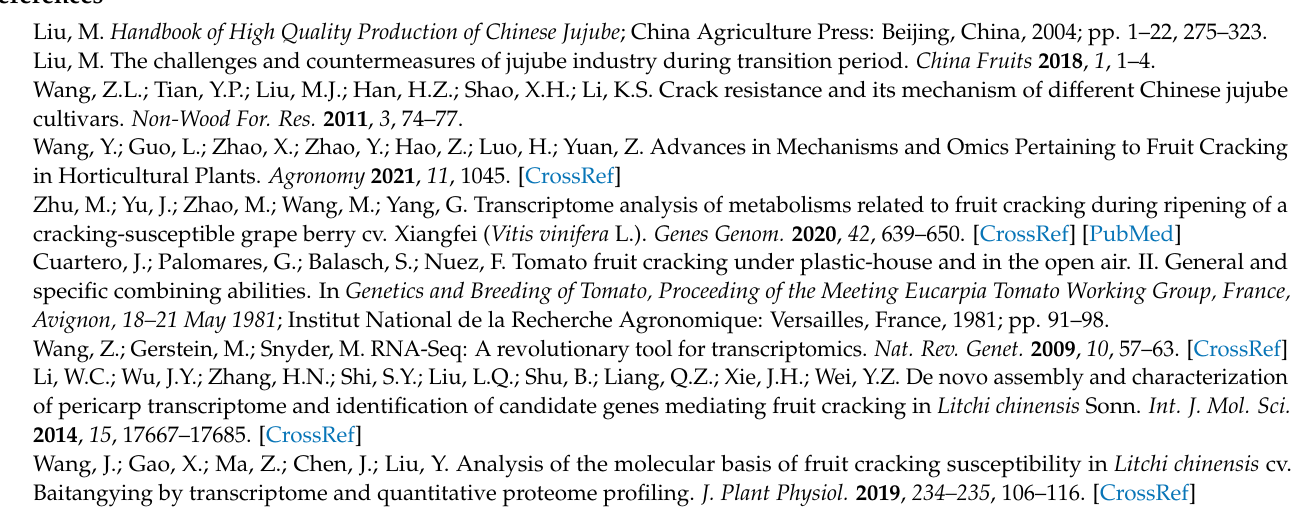
The Coverage of sequencing. Figure S3: Distribution of differentially expressed transcription factors in gene families. Figure S4: Hypothesized mechanisms of fruit cracking in jujube. Table S1: Primer used for qRT-PCR. Table S2: Summary of sequence assembly after Illumina sequencing. Table S3: Clean reads mapped to the reference genome. Table S4: Complete lists of differentially expressed genes in three groups based on pairwise comparisons. Table S5: Annotation summaries of DEGs. Table S6: KEGG pathways of the DEGs in CC vs. NC, CJ vs. NJ, and NJ vs. NM. Table S7: DEGs involved in important processes during fruit cracking. Table S8: Details regarding the DEGs used for the trend analysis in the NM, NJ, and CJ